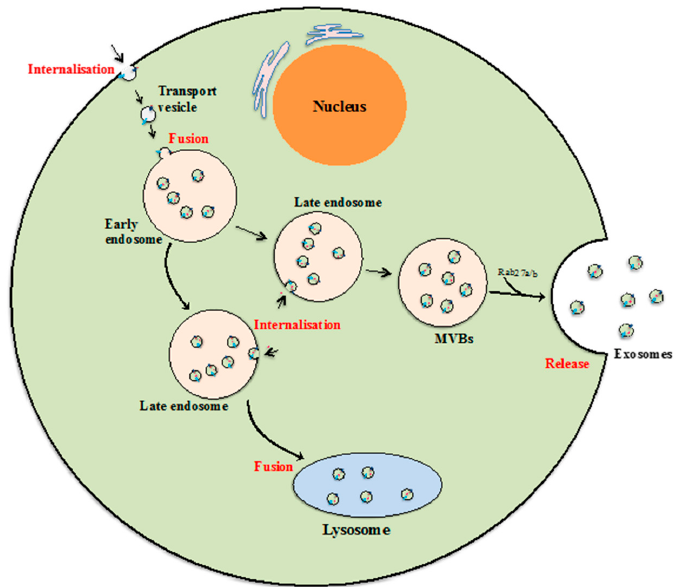
Figure 4. Exosome biogenesis. Beginning from internalization of membrane proteins and lipid complexes by endocytosis, endocytotic vesicles are delivered to early endosomes, which fuse with each other resulting in formation of late endosomes/multivesicular bodies (MVB). MVBs either release exosomes by fusion with the cellular membrane, or their contents are degraded if they fuse with lysosomes [40,42,43]. The key steps of the exosomal formation and development process are highlighted in red.